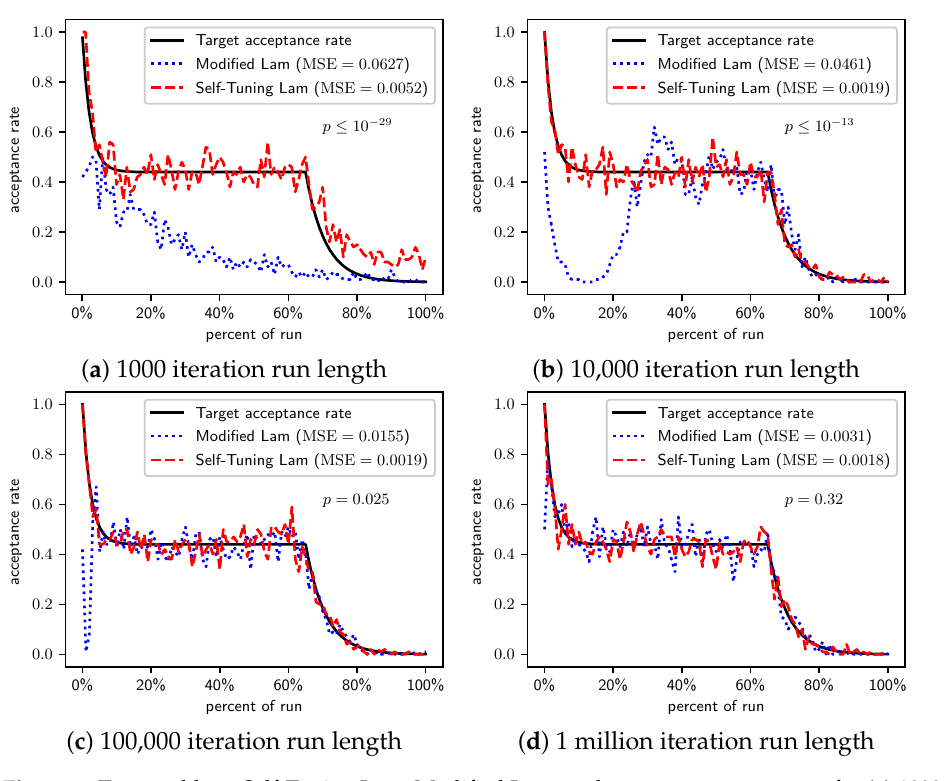
Figure 6. Trap problem: Self-Tuning Lam, Modified Lam, and target acceptance rates for ( a ) 1000 iter- ations, ( b ) 10,000 iterations, ( c ) 100,000 iterations, and ( d ) 1 million